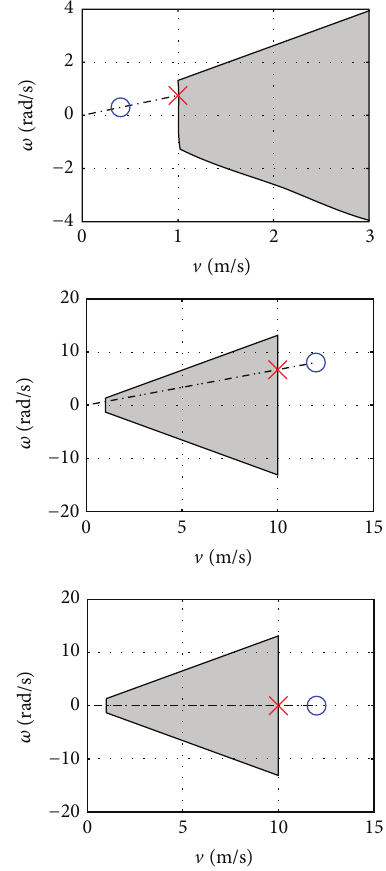
Figure 8: Region 1 examples for second stage